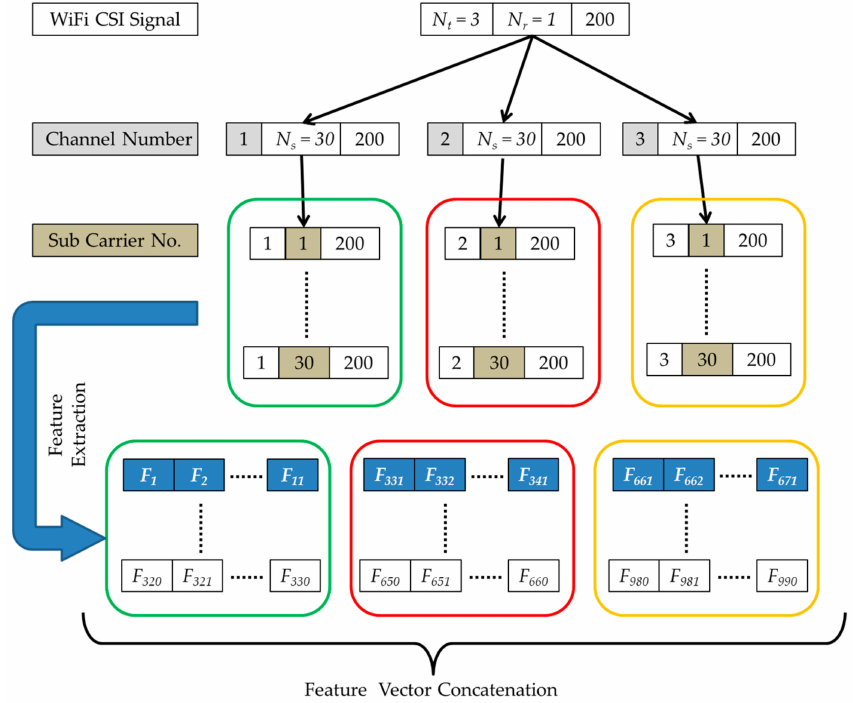
Figure 7. Cumulant feature